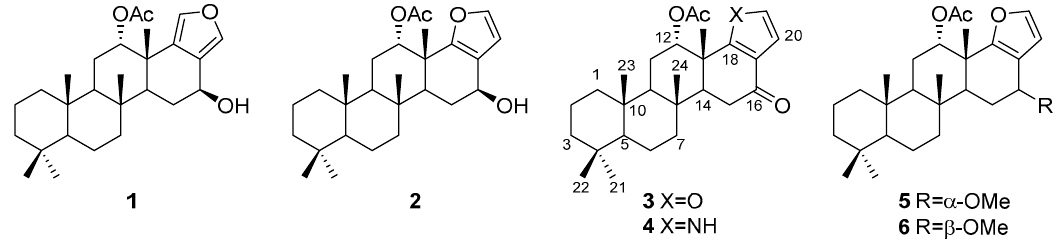
Figure 1. Structures of the obtained furan- and pyrrole-containing scalarane analogs.